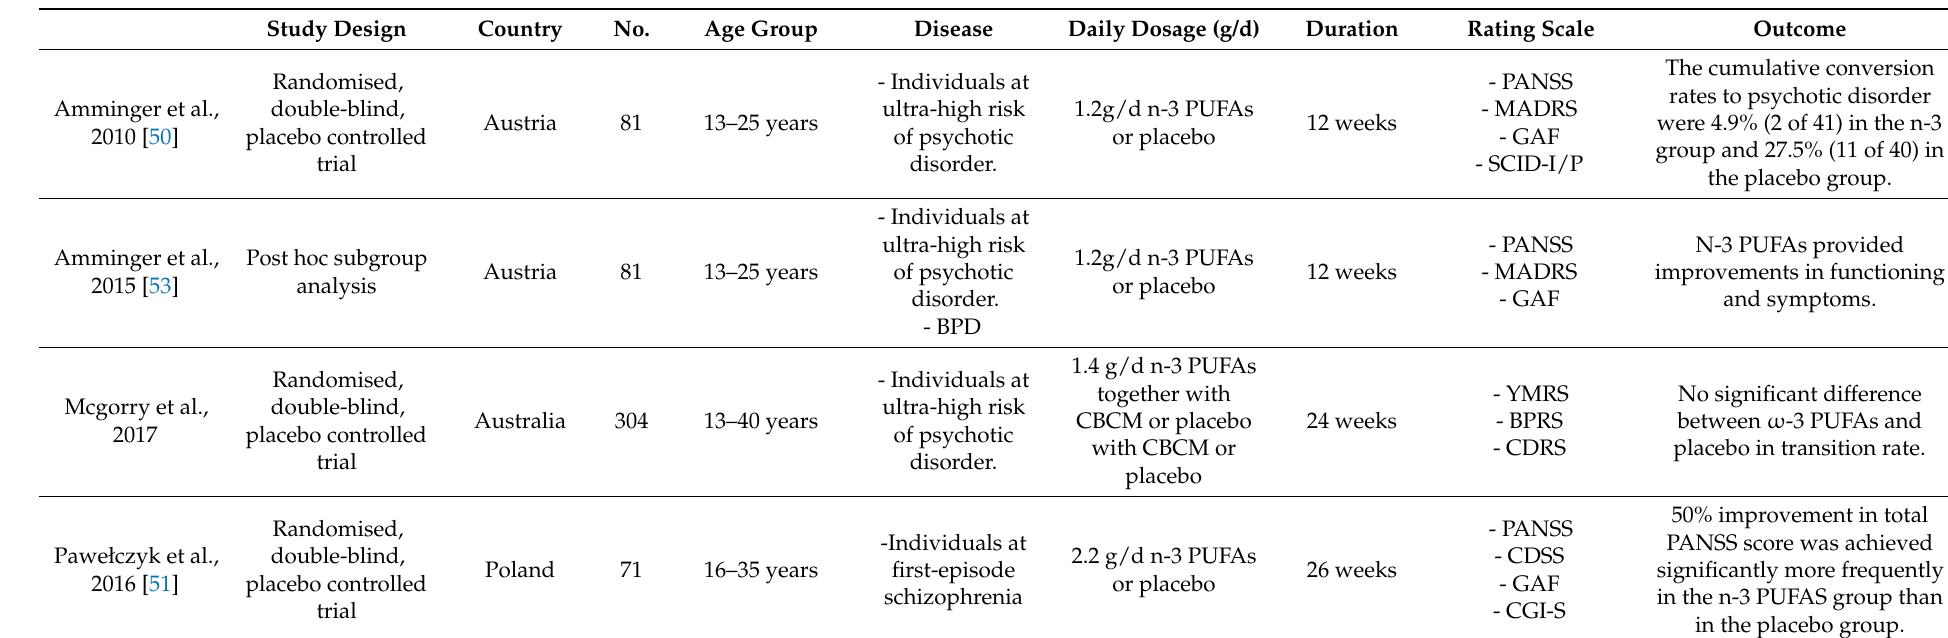
Table 1. Schizophrenia and